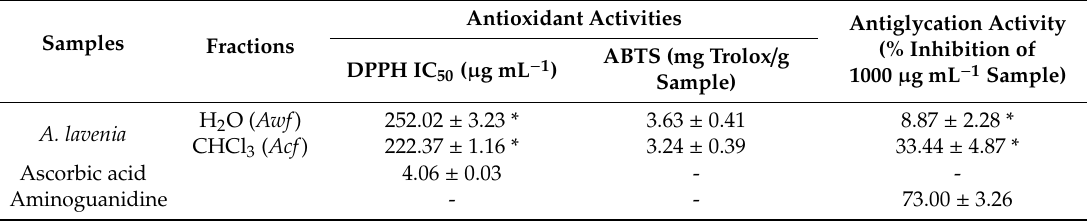
Table 1. In vitro antioxidant and antiglycation activities of A. lavenia fractions.